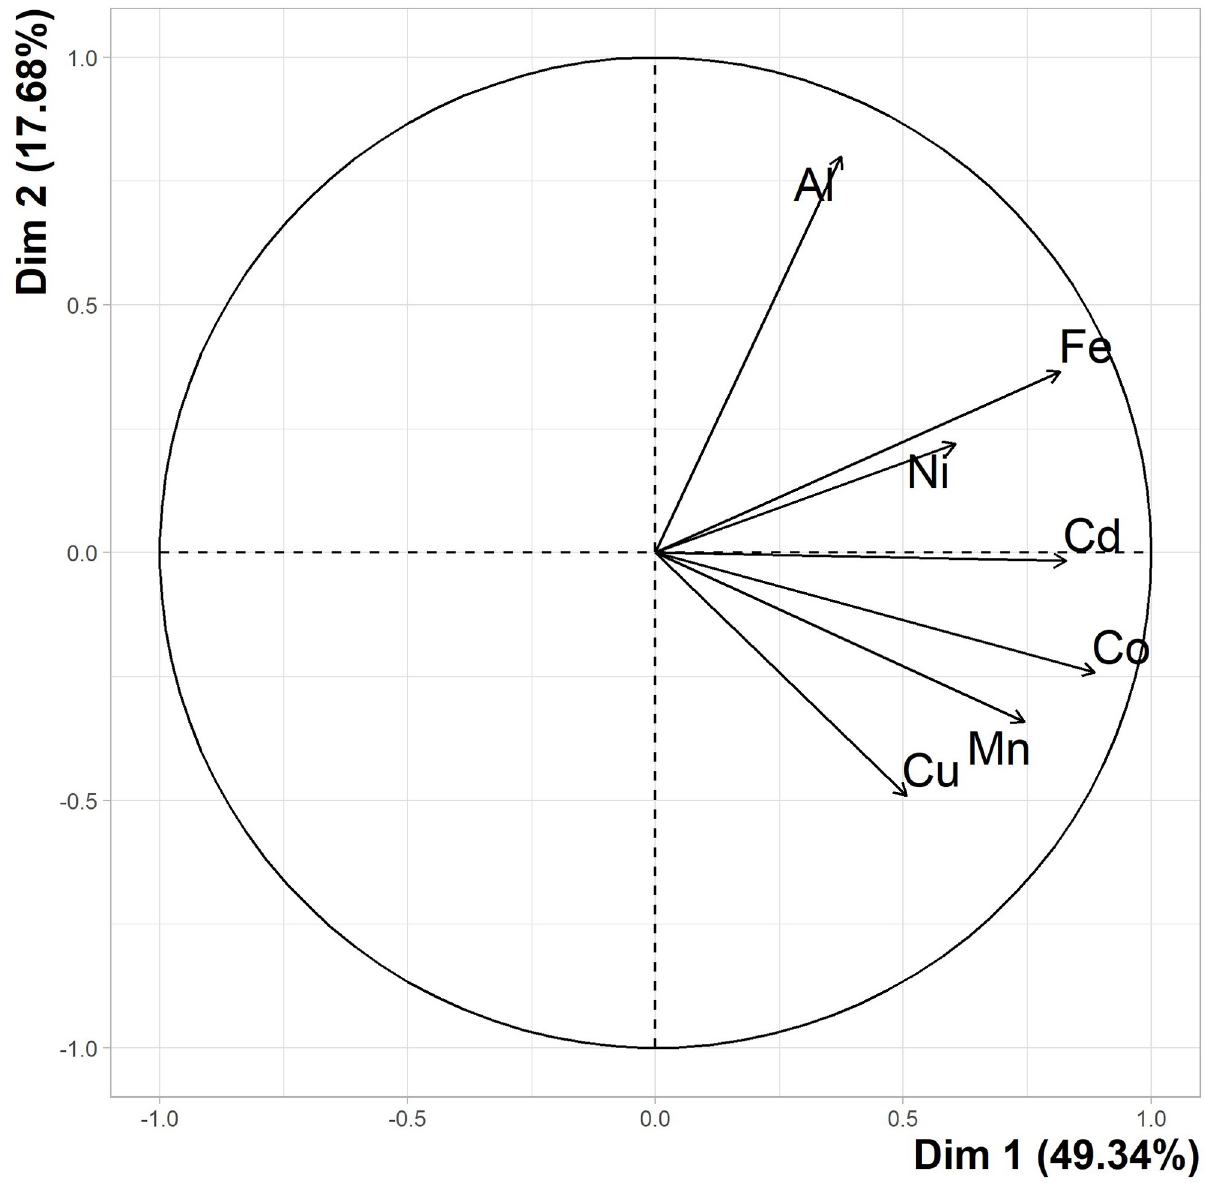
Fig 2. PCA Variable loading plot. Plot of the findings of all metal concentration data from seagrass collected from coastal sites of this study and baseline data obtained from HWK and provided by Thomas et al [5]. Dimension 1 (Dim 1) represents 49.34% of total variations and Dim 2 represents